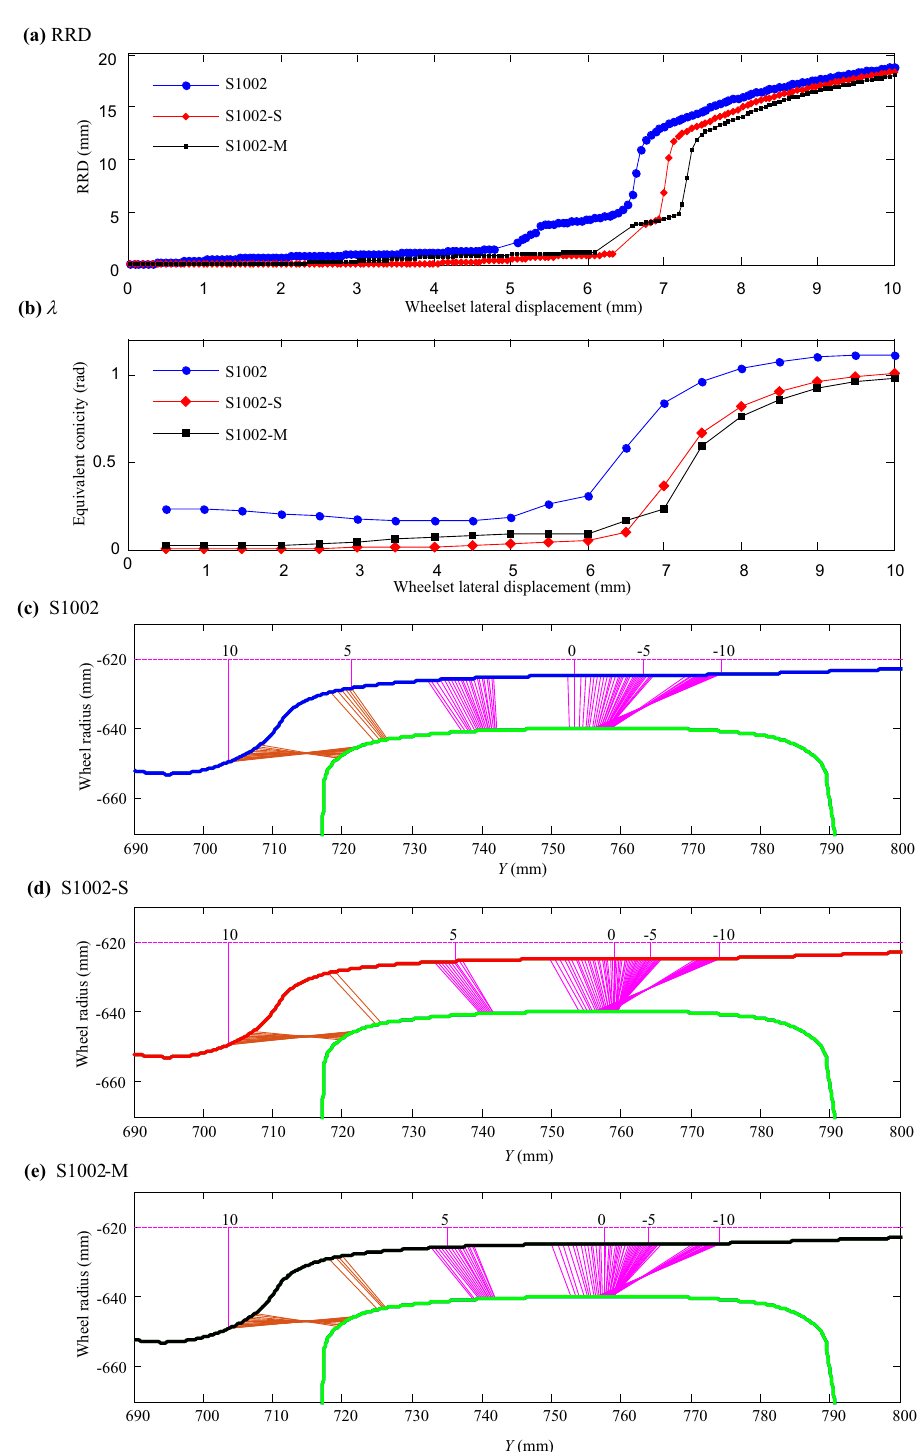
Fig. 17 RRD ( a ), equivalent conicity ( b ), and contact distribution ( c – e ) of the S1002, S1002-S, and S1002-M